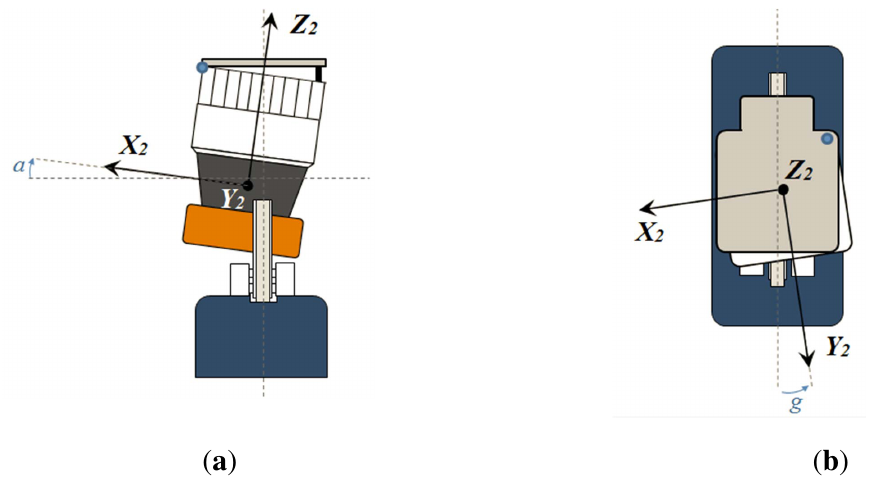
Figure 7. Two types of mechanical misalignments intentionally introduced in UNOlaser: angles a ( a ) and g ( b